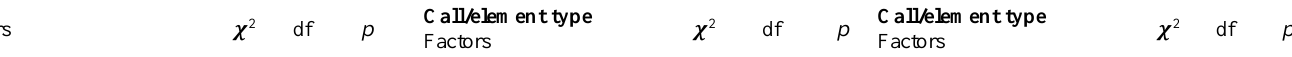
Test Results for Generalized and Linear Mixed Models Testing for Predator Type, Group Size (Conspecific and Flock Size) and Composition (Presence of Blue, Great, and Coal Tits) on Ways of Encoding Information about Predator Threat for Marsh Tits. § Indicates the Model Residuals were not Normally Distributed, L and Bc Indicate that Data was Log (L) or Box-Cox (Bc) Transformed if Residuals were not Normal for Linear Mixed Models. Bonferroni Corrected P-Values Based on the Number of Models are .017.